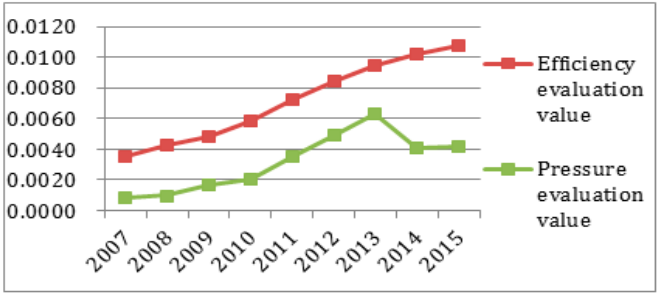
Figure 6. Evaluation value change in the economic subsystem.